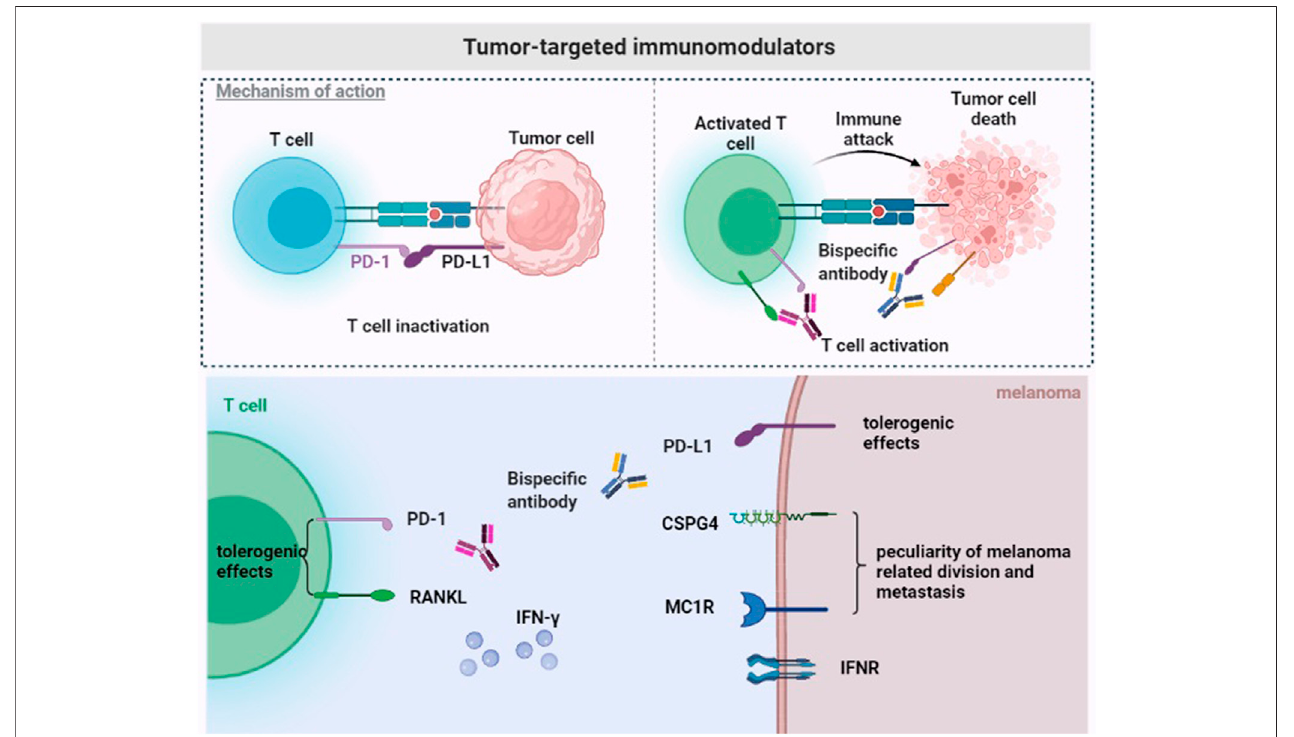
FIGURE1| Tumor-targetedimmunomodulators.Theimmunosuppressivetumormicroenvironmentofmelanoma.Bispeci fi cantibodiesexertanti-tumoreffectsby binding to tumor-speci fi c antigens (CSPG4/MC1R) and PD-L1, or to double immune checkpoints (RANKL and PD-1) on the surface of T cells.